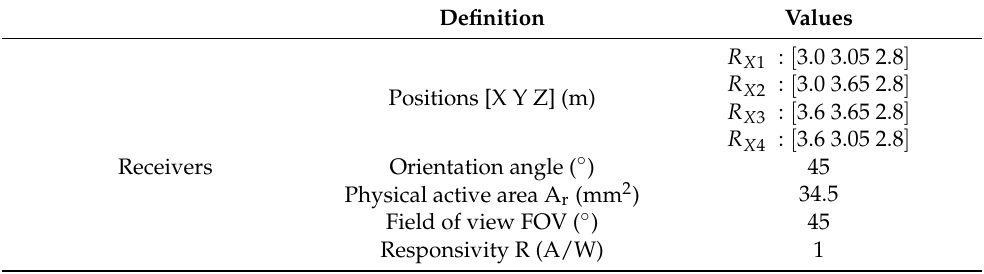
Figure 1. Top view of studied environment and Rx locations. Table 1. List of Rx parameters.